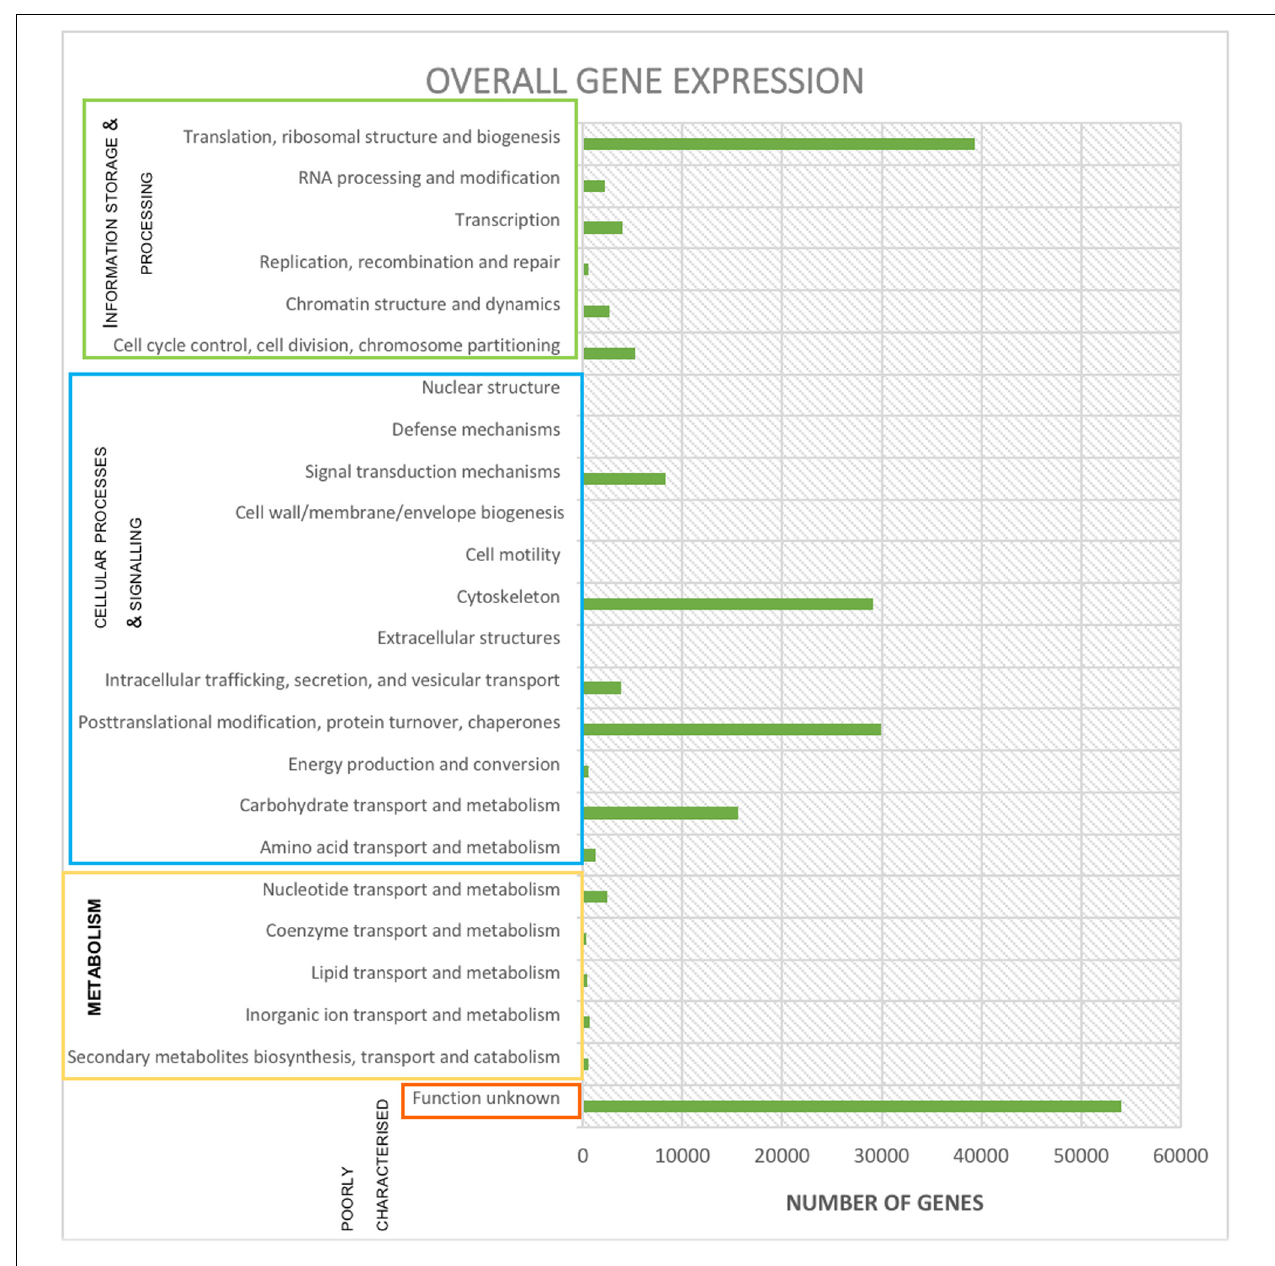
FIGURE 3 | Expression (reads) per functional subcategory from the protozoal metatranscriptome using Bowtie2, FeatureCounts and EggNOG online mapper. Subcategories are collated into the appropriate main